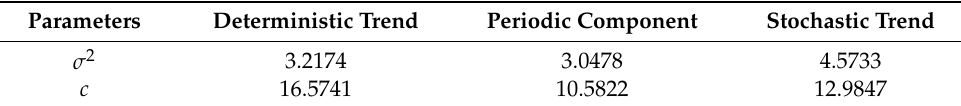
Table 2. The optimal values of σ 2 and c .